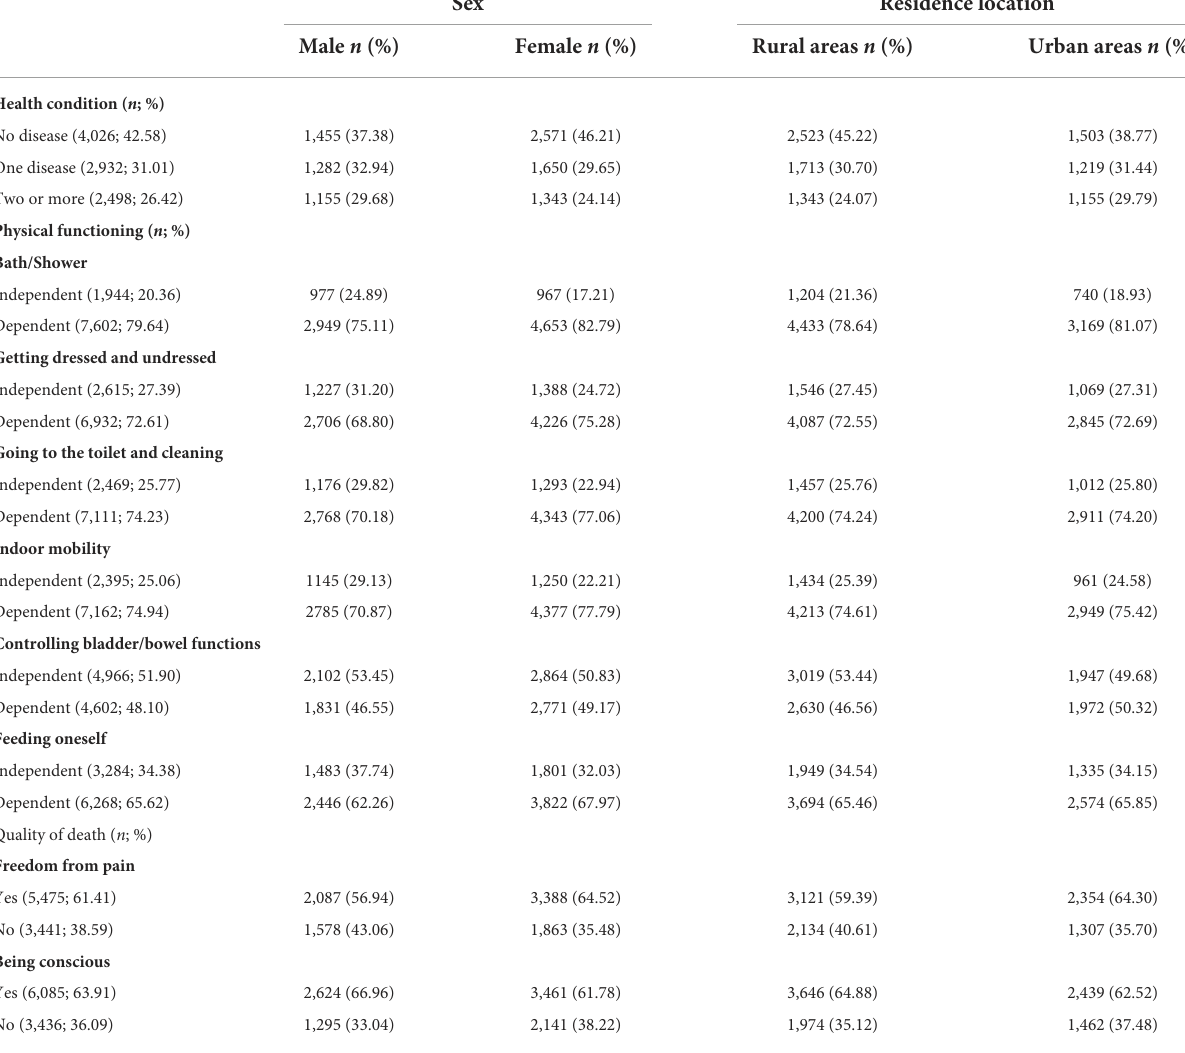
TABLE 2 Descriptive statistics on health condition, physical functioning, and quality of death by sex and location. Sex Residence location Male n (%) Female n (%) Rural areas n (%) Urban areas n